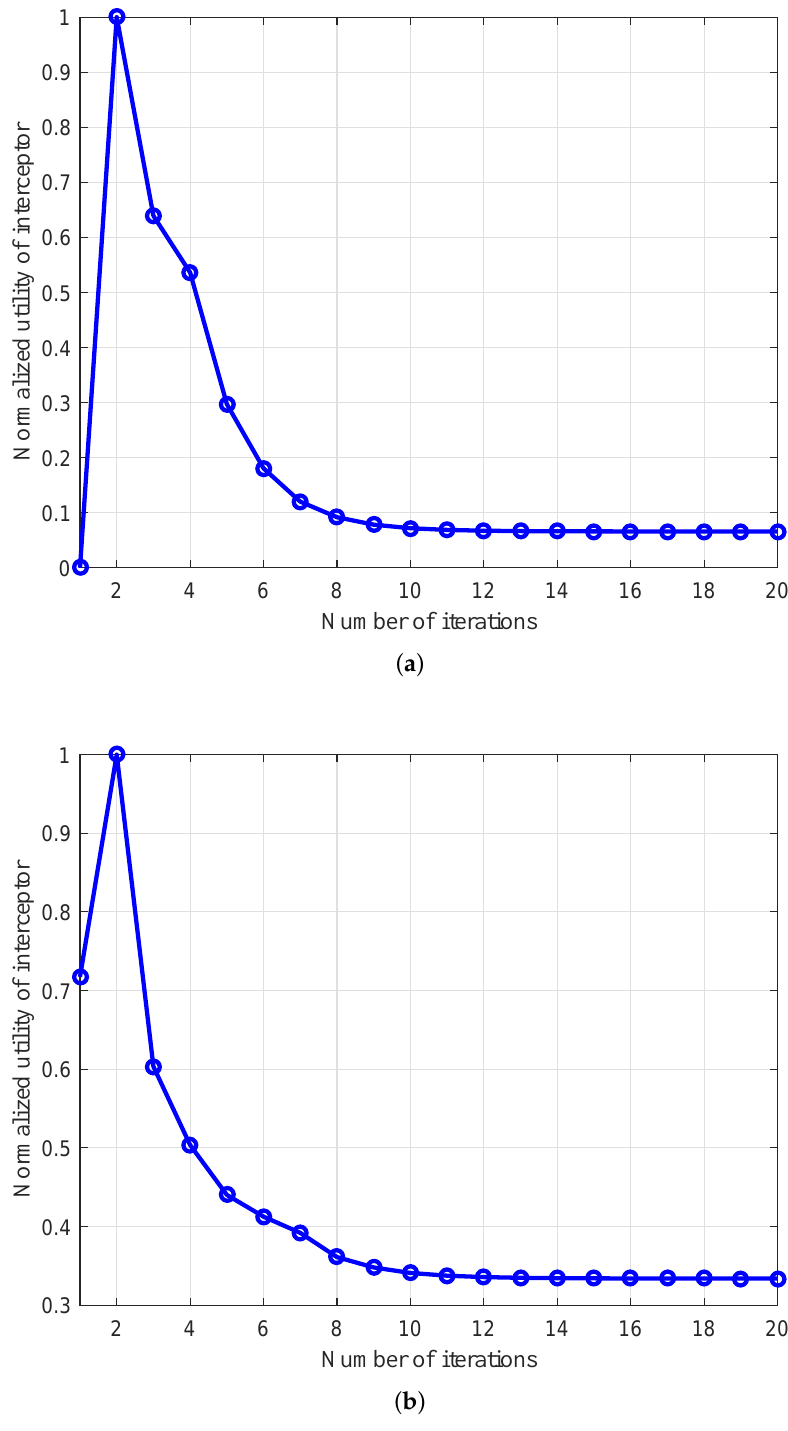
Figure 9. Convergence behavior for the normalized utility of intercept receiver in the second case: ( a ) Target position is [ 0,0 ] km; ( b ) Target position is [ − 30, − 40 ]